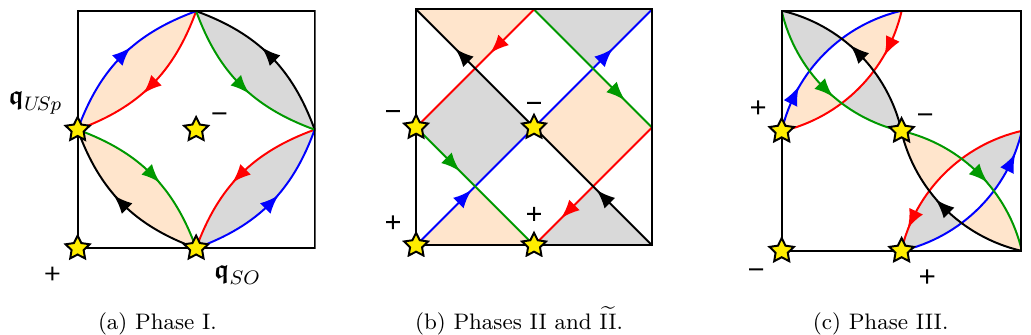
Figure 4. Theories arising at the cusps of the conformal manifold for the C C ( F 0 ) theory modded out by the O3 action, for different choices of flux. Due to the high degree of symmetry of C C ( F 0 ) some of the flux choices lead to isomorphic choices, which we have denoted as phases II and e II in this figure. [Figures reproduced from